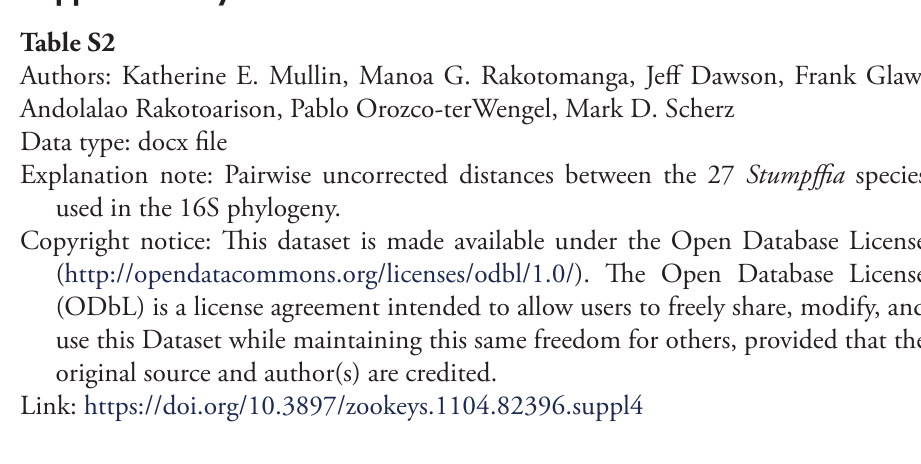
Explanation note: Pairwise uncorrected distances between the 27 Stumpffia species used in the 16S